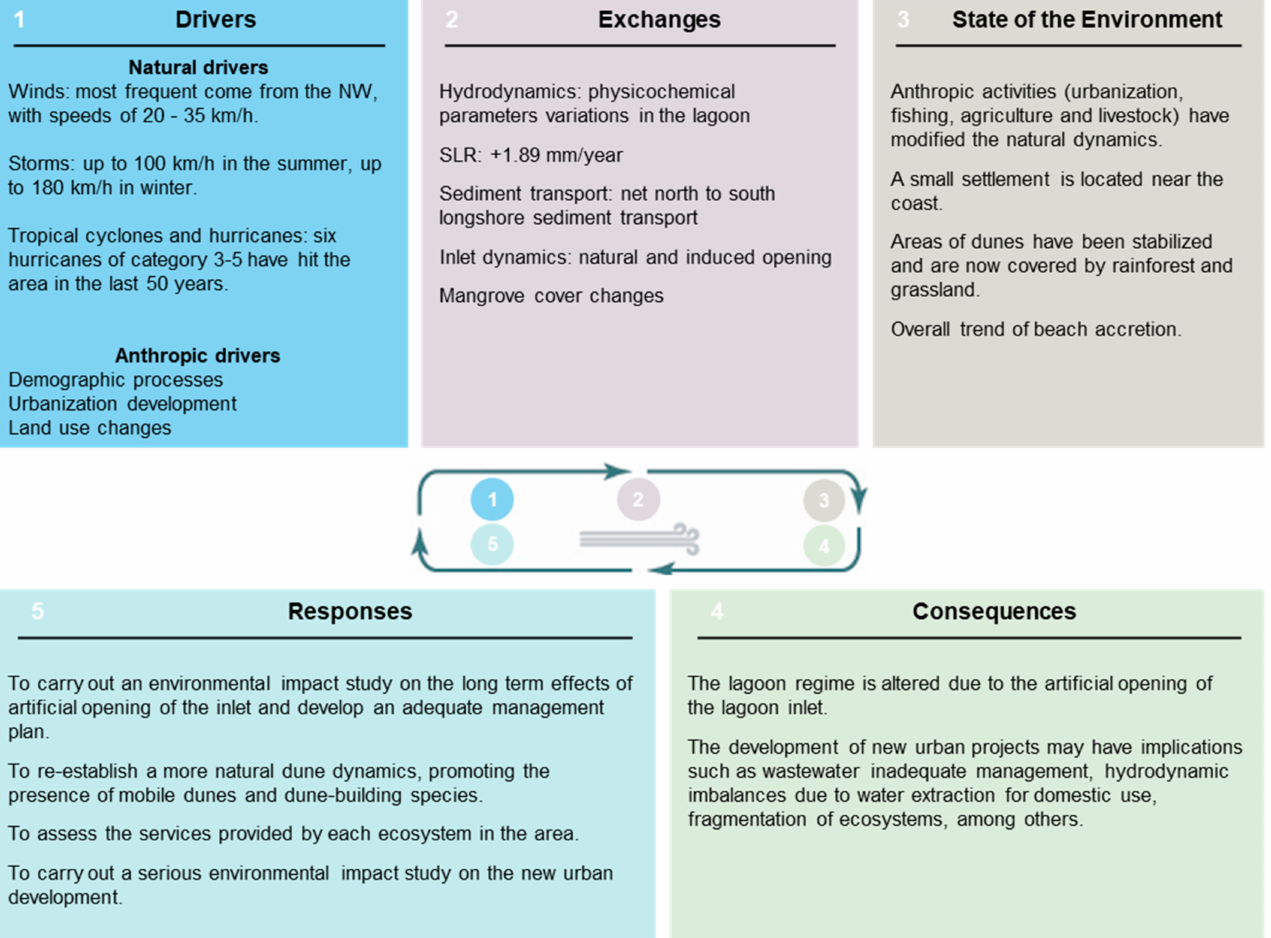
Figure 12. DESCR for La Mancha,